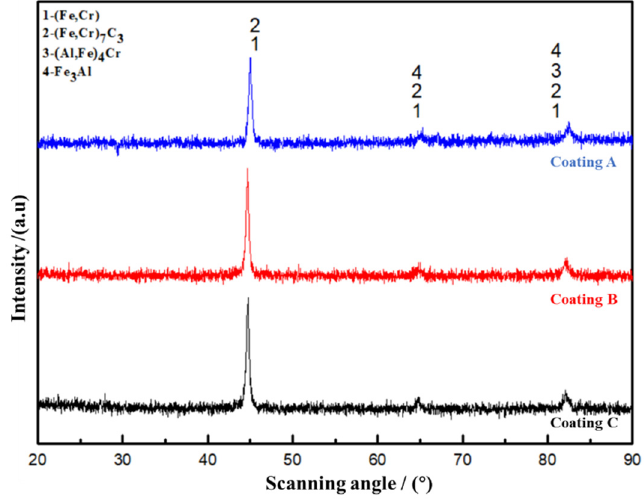
Figure 7. XRD diffraction pattern of coatings A (0 mT), B (20 mT), and C (40 mT).